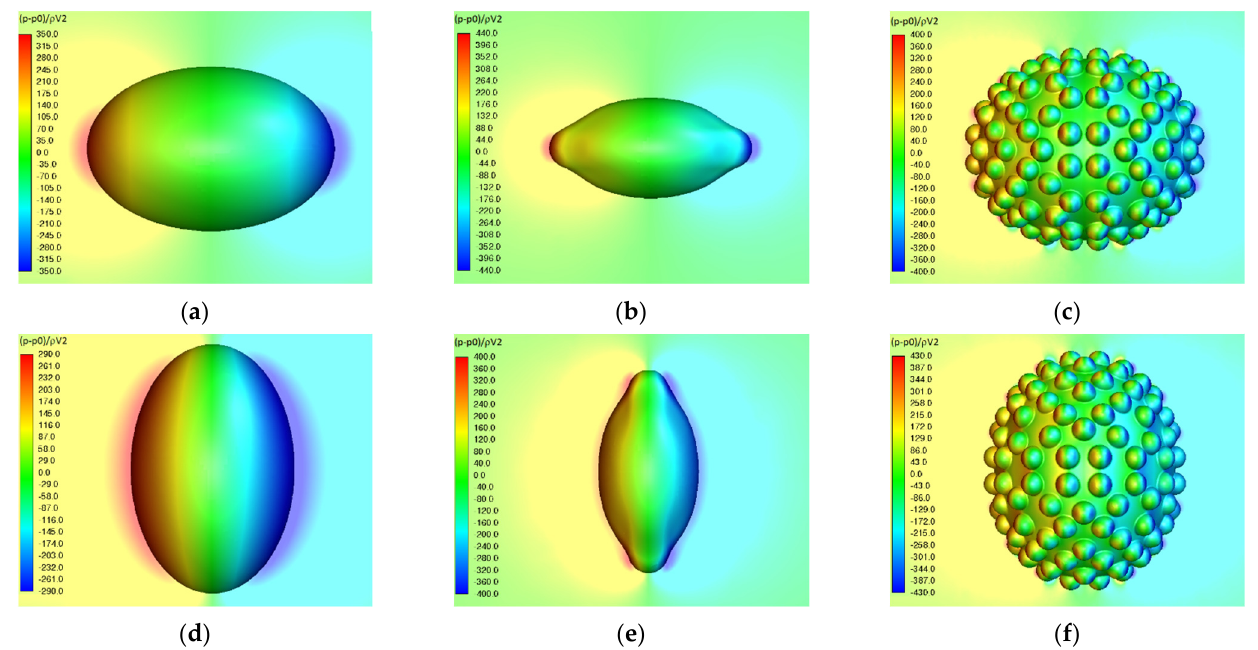
Figure 12. Dimensionless relative pressure distribution over the egg surface and in the symmetry plane in egg’s nearfield, for Re = 0.01, ( a ) OES, θ = 0°, ( b ) TRI, θ ° = 0, ( c ) ASC, θ = 0°, ( d ) OES, θ = 90°, ( e ) TRI, θ ° = 90, ( f ) ASC, θ = 90°.